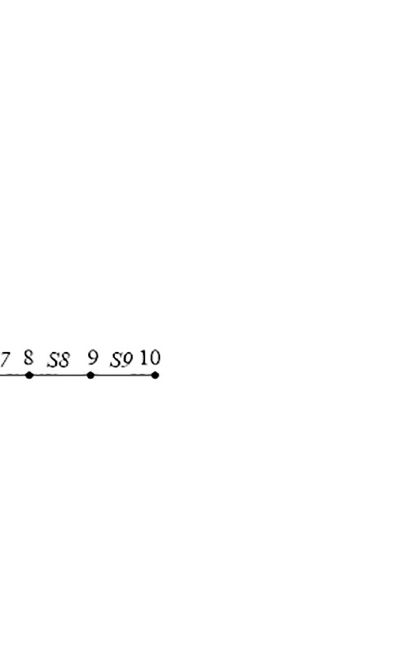
Fig 6. Simplified distribution